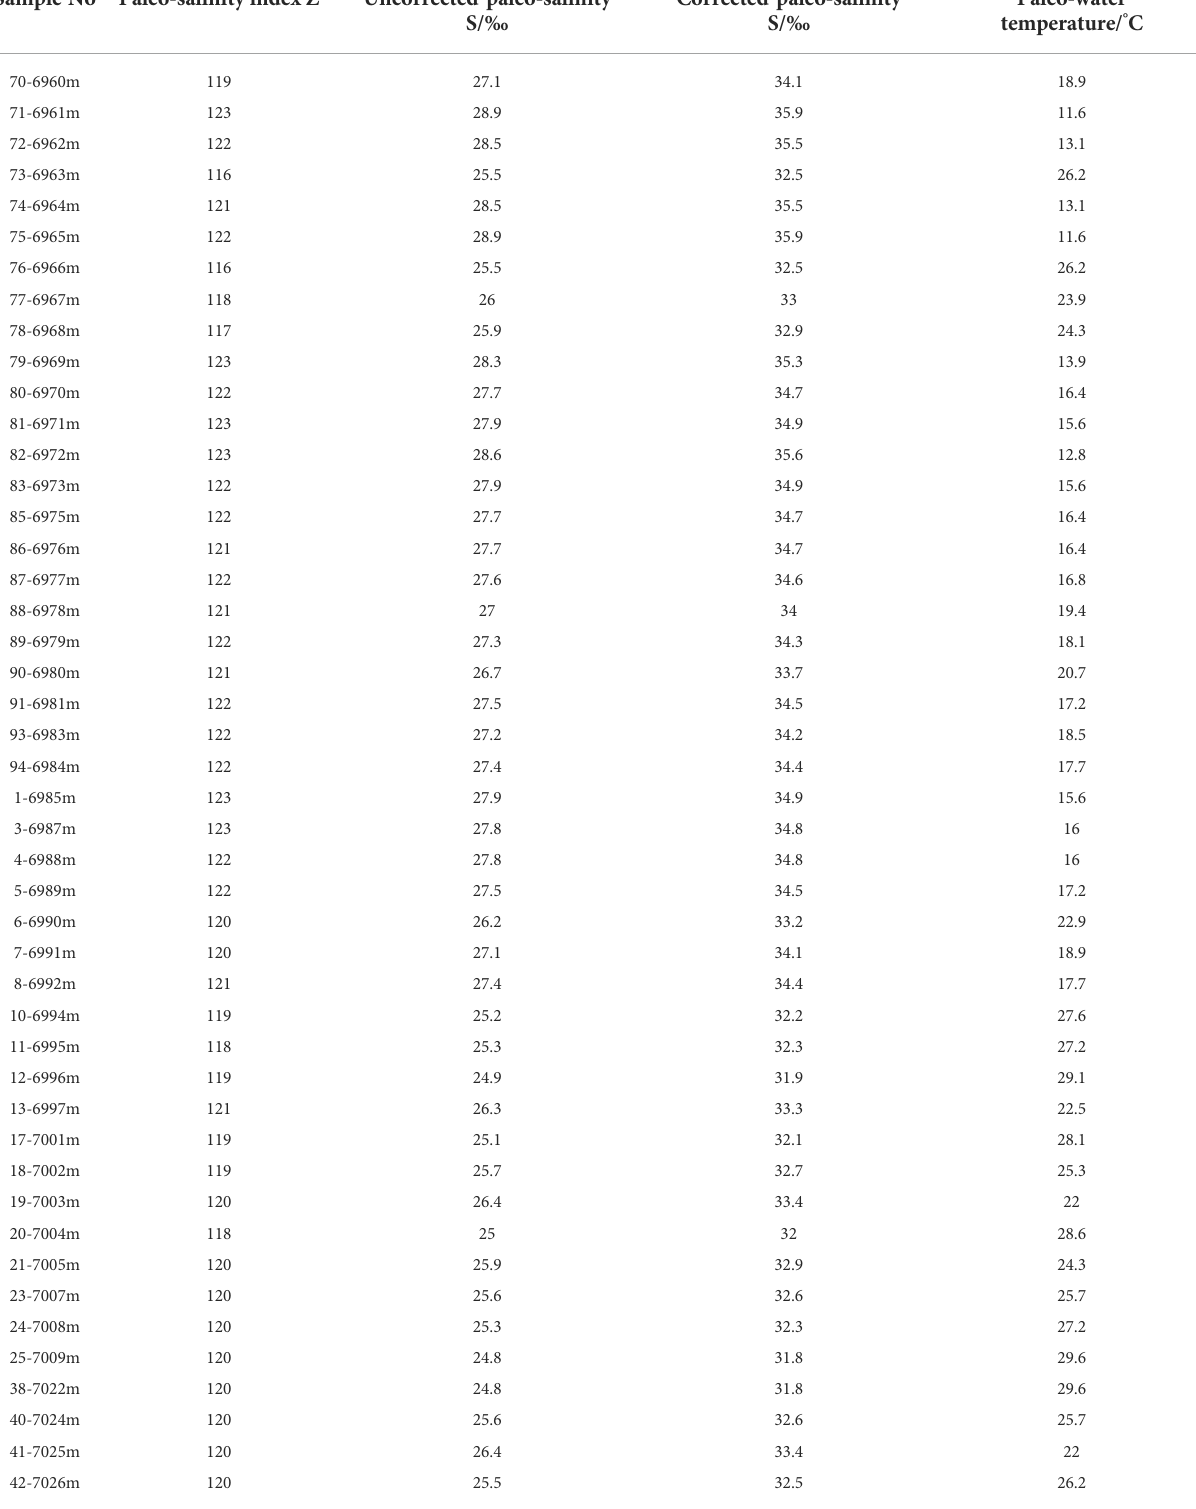
TABLE 3Dateofpaleotemperatureandpaleo-salinityofthe fi rst member ofCanglangpu Formation oftheCambrianSeries 2from WellJT1in central Sichuan Basin (Ma at el.,